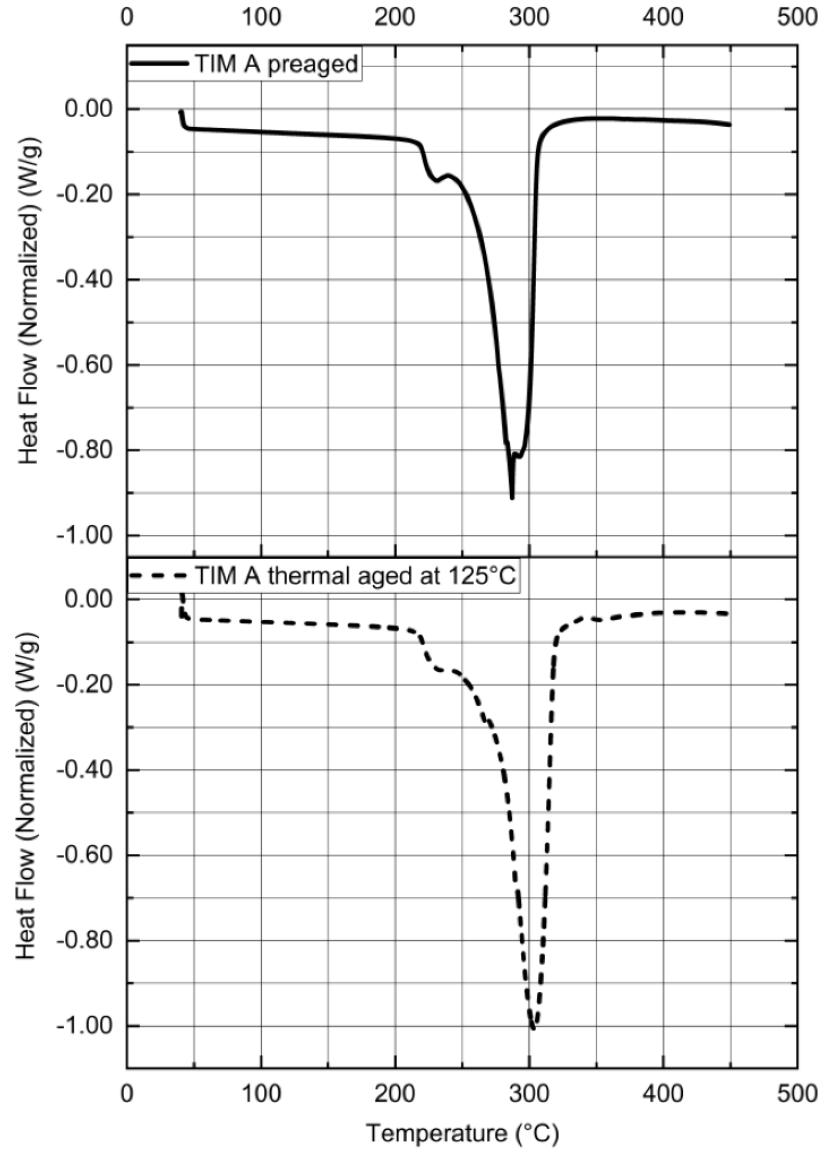
Figure 13. Normalized heat flow vs. temperature of TIM A.